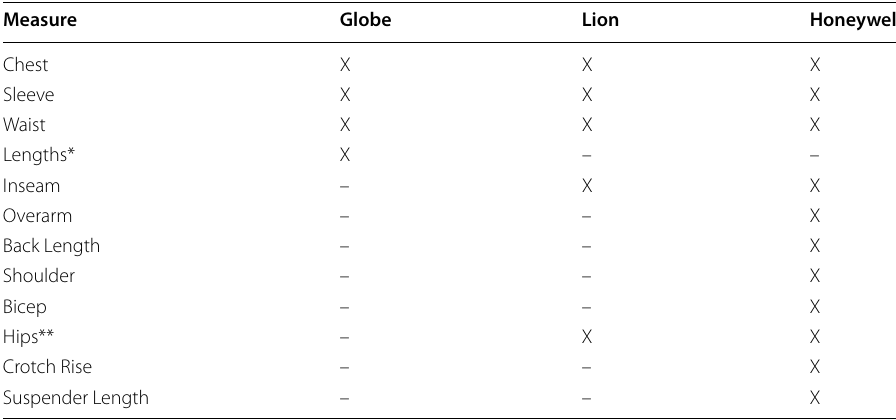
Table 1 Measures communicated by the top Personal Protective Equipment manufacturers for coat/pant sizing